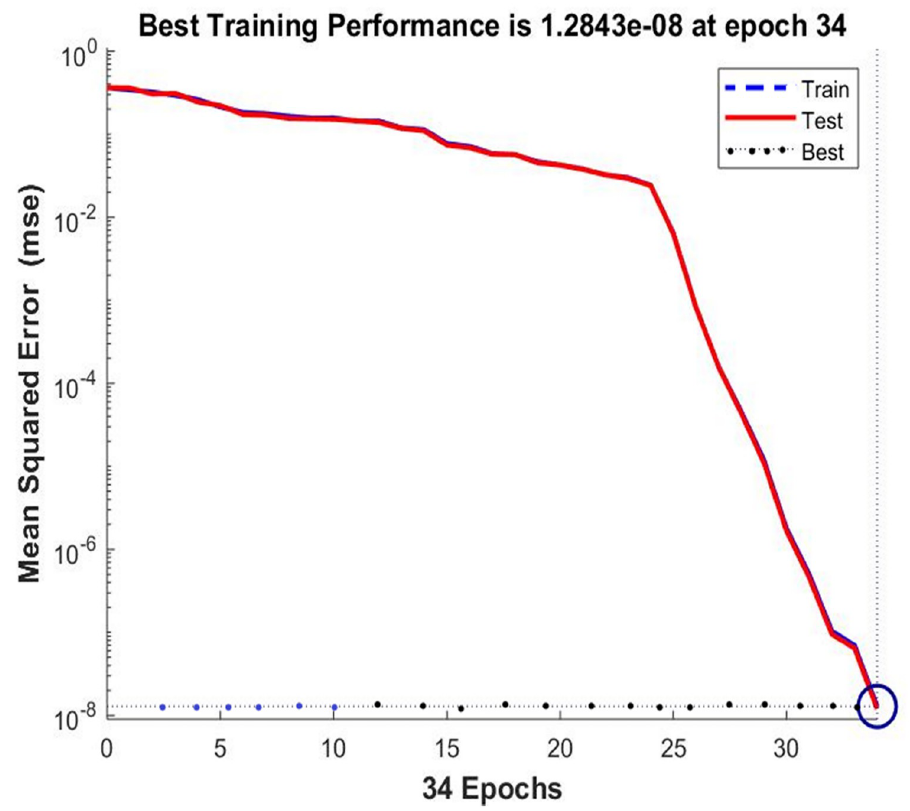
Fig 3. Training error versus epochs (an epoch is a whole batch of input